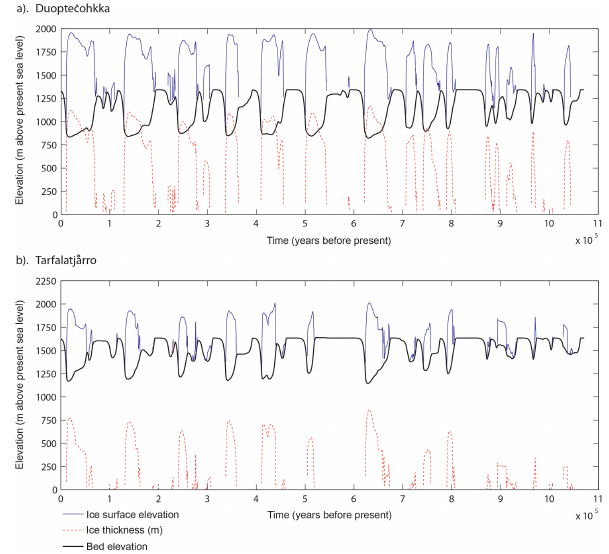
Figure 7. Modelled ice sheet surface elevation, ice thickness, and bedrock response to ice sheet loading and unloading for (a) Duopteˇcohkka and (b) Tarfalatjårro over the last 1.07Ma. These data were generated using a 3-dimensional ice-dynamical model forced by the Lisiecki and Raymo (2005) stack of global benthic δ 18 O records and the ELRA bedrock model (Bintanja et al., 2002,